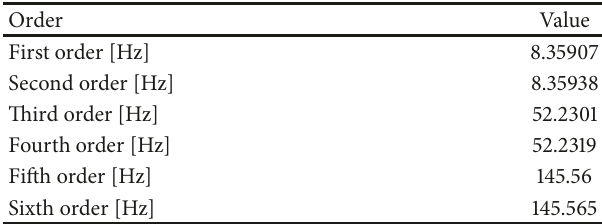
Table 12: The first six-order mode natural frequency of main